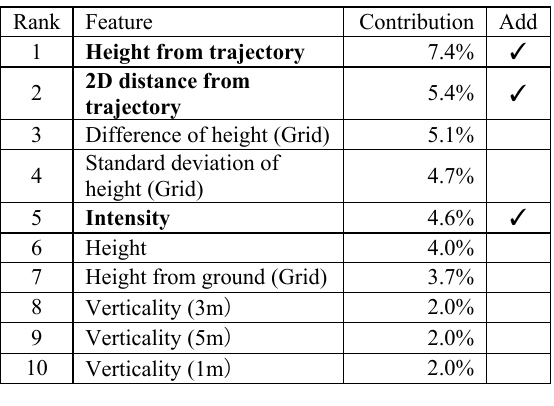
Table 2 . Feature contribution